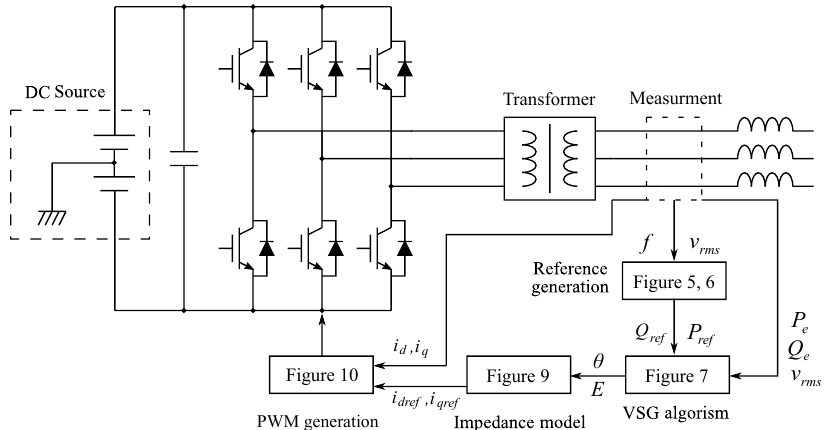
Figure 3. Overall VSG